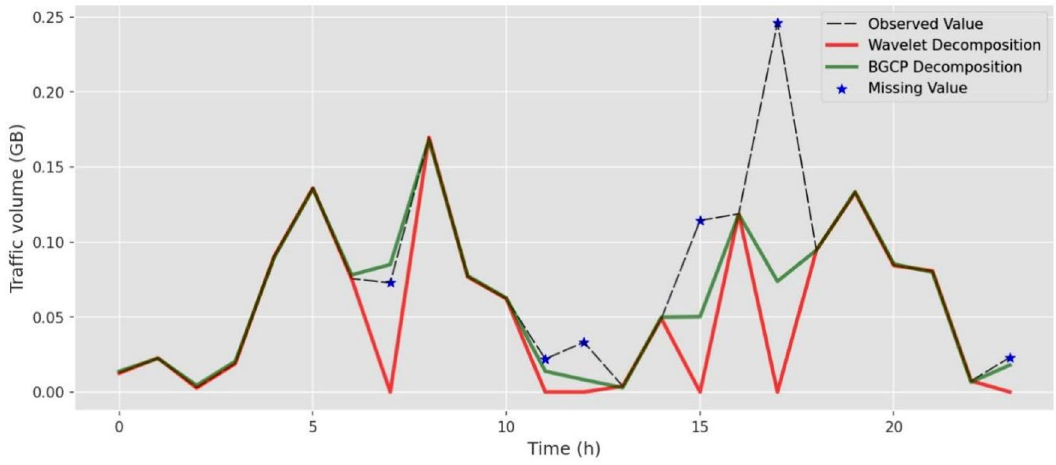
Fig. 7 Filling results of wavelet decomposition and BGCP decomposition on real dataset